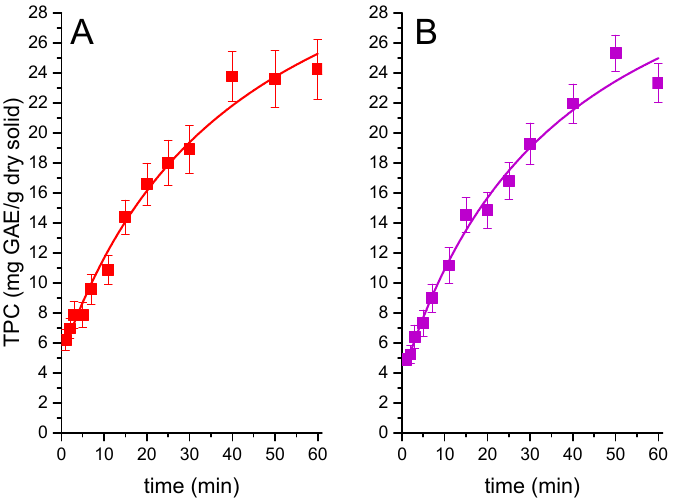
Figure 3. Kinetic analysis of the extraction process of AP employing ( A ) ethylene glycol 90% at 70 ◦ C and ( B ) propylene glycol 90% at 70 ◦ C obtained by the Folin–Ciocalteu method. The lines show the fitting of the second-order kinetic model shown in Equation (1).